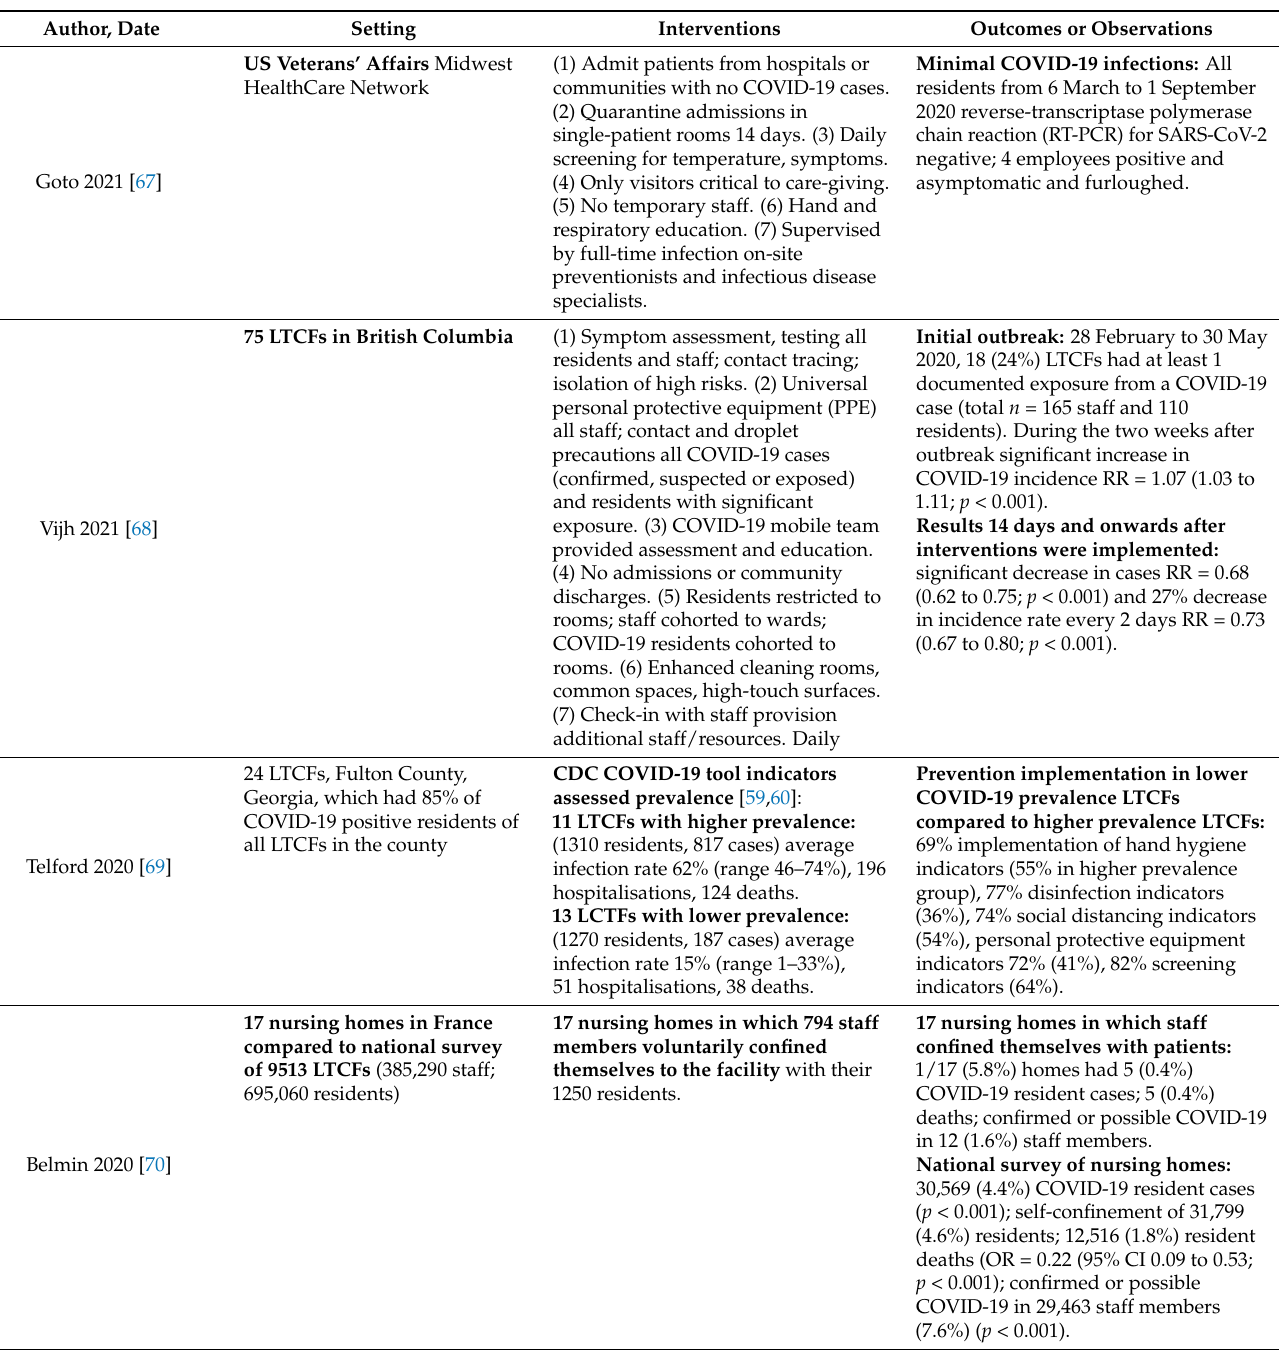
Table 7. Preventive COVID-19 interventions and outcomes in